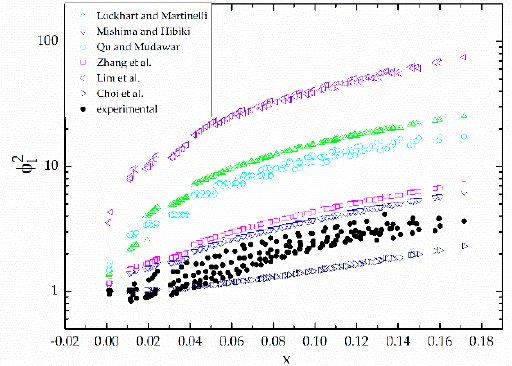
Figure 7. Comparison between the measured two-phase multiplier and previous correlations. Table 3. Two-phase frictional pressure gradient correlations based on the separated flow model and corresponding MAE in predicting present frictional pressure drop data.